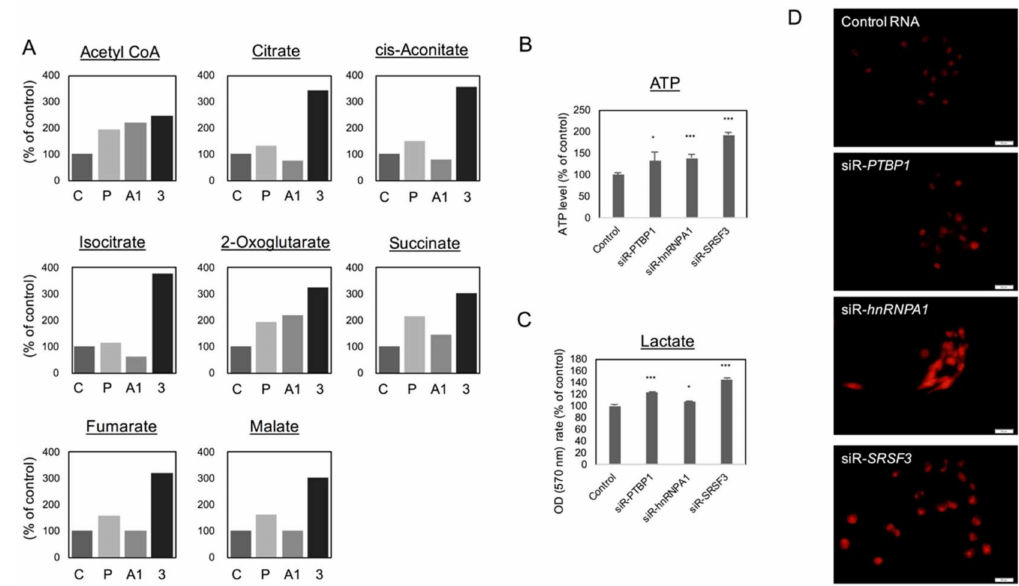
Figure 3. Effects on DLD-1 cellular metabolism of silencing of PTBP1 , hnRNPA1 , or SRSF3 . ( A ) Metabolome analysis of DLD-1 cells transfected with siRNA for PTBP1 , hnRNPA1 , and SRSF3 (5 nM) for 72 h (C, Control RNA; P, siR- PTBP1 ; A1, siR- hnRNPA1 ; 3, siR- SRSF3 ); ( B ) ATP assay for DLD-1 cells transfected with